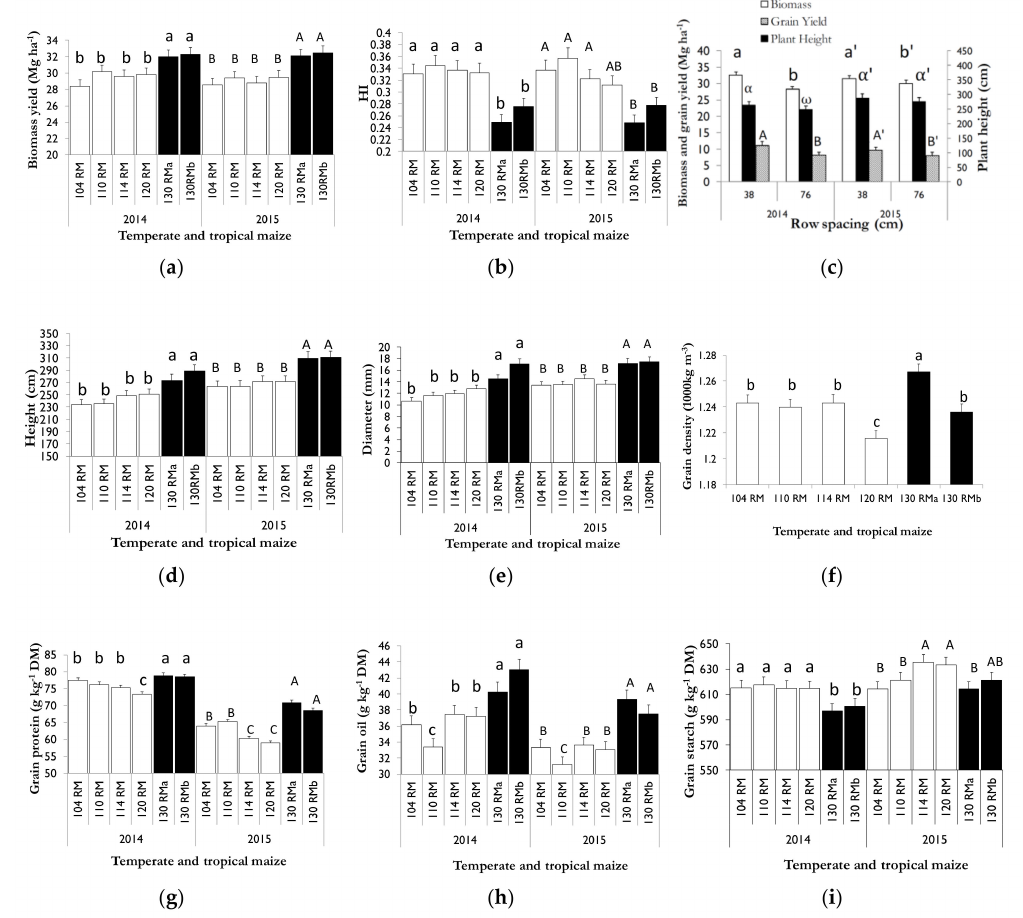
Figure 1. ( a ) Total biomass, ( b ) harvest index (HI), ( d ) plant height, ( e ) stem diameter, ( f ) grain density, ( g ) grain protein, ( h ) grain oil, and ( i ) grain starch for temperate (white bars) and tropical (black bars) maize during 2014 and 2015 growing seasons. ( c ) Plant height (black bars), total biomass (white bars), and grain yield (striped bars) combined for temperate and tropical maize for two row spacings and two growing seasons. Treatments were determined within each year. RM stands for relative maturity type, and two different RM ( a , b ) are presented when corn of relative maturity of 130 is evaluated. Different letters on the top of standard error bars mean significant differences among treatments ( p >